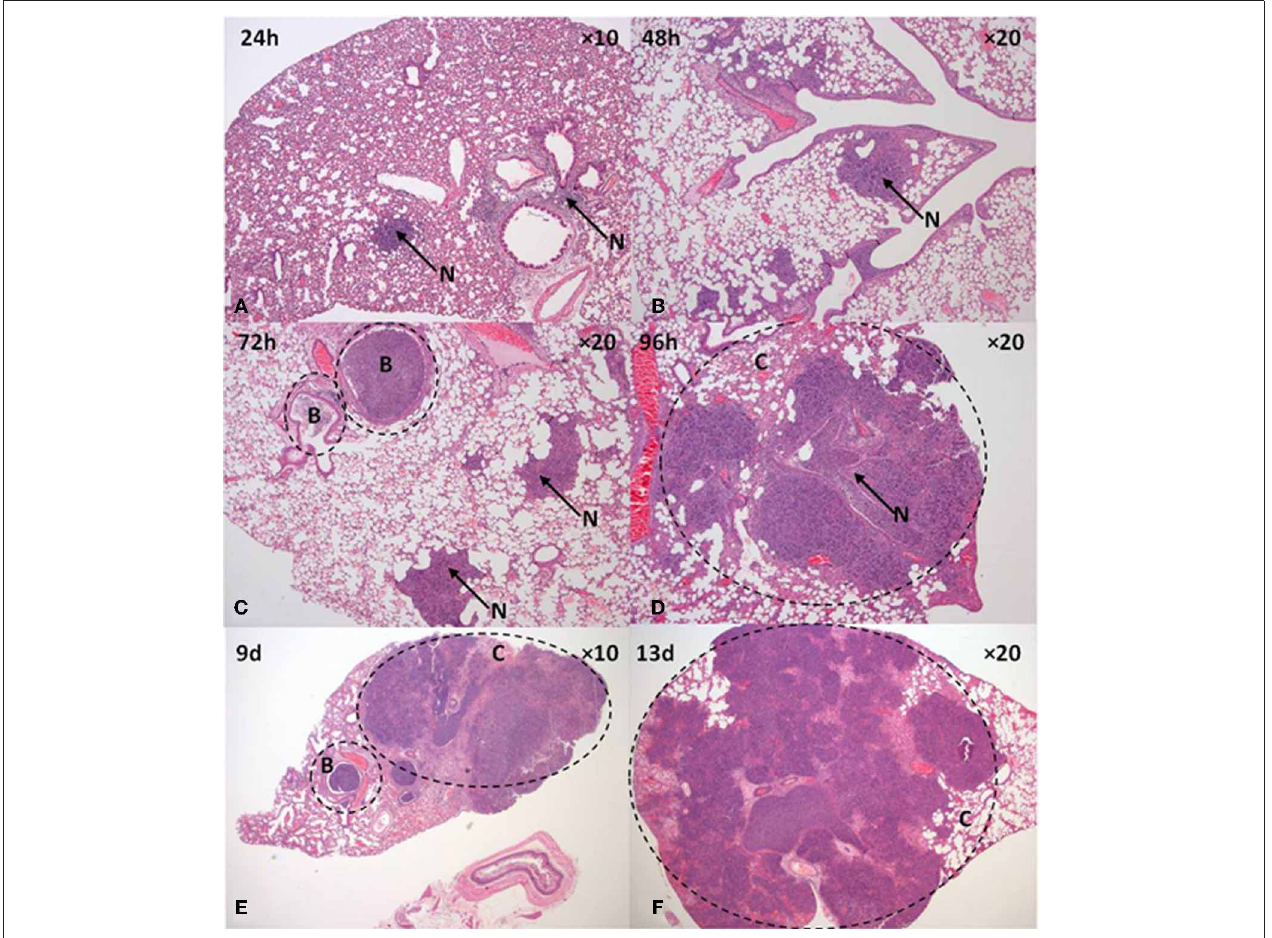
FIGURE 3 | Pathology of the lung after inhalation of B. pseudomallei K96243 aerosolized in 12 µ m aerosol particles. (A) 24h, (B) 48h, (C) 72h, (D) 96h, (E) 9 d, and (F) 13 d. B, bronchiole, C, consolidated tissue, N, suppurative